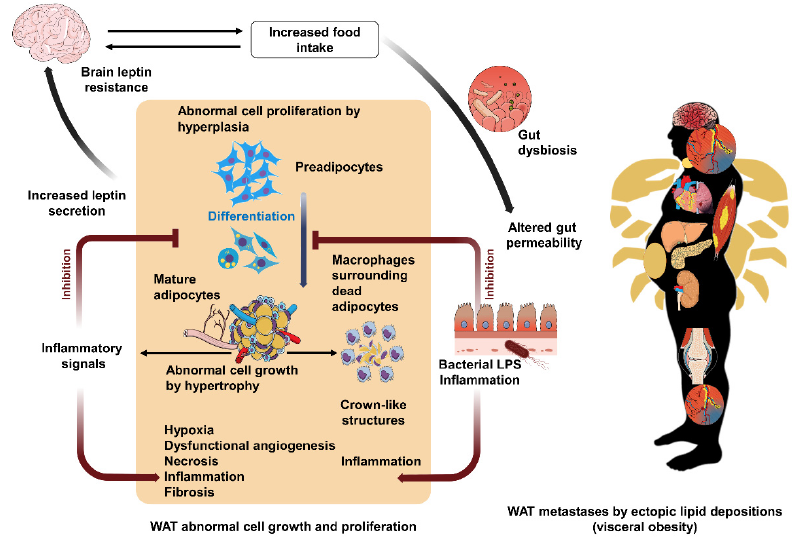
Figure 1. Vicious circles of white adipose tissue (WAT) abnormal cell growth and proliferation, and fat mass metastases. In obesity, the brain becomes less sensitive to the satiety hormone leptin, and this favors feelings of hunger and increases food intake. This further boosts the positive energy balance, induces intestinal flora dysbiosis and augments gut permeability to the bacterial endotoxin lipopolysaccharide (LPS), which is highly inflammatory. LPS inhibits the differentiation of preadipocytes to mature fat cells. Thus, more preadipocytes are formed to generate new adipocytes to store the body’s excess of energy, which enhances obesity by hyperplasia. The inhibition of adipogenesis induces mature adipocytes to undergo extreme abnormal cell growth to pack lipids that surpass their maximum storage capacity through excessive hypertrophy. This further causes hypoxia, fibrosis, and eventually cell necrosis. Massive WAT hypertrophy might induce severe hypoxia that can trigger angiogenesis, which, however, generates fragile and dysfunctional capillaries that further boost tissue inflammation. The dead adipocytes attract immune cells—macrophages—to form inflammatory crown-like structures. The affected WAT secretes high leptin levels to the brain to reduce food intake; however, the brain becomes insensitive to leptin due to the ongoing processes of obesity. WAT in the obese organism further secrets inflammatory cytokines to promote the inflammatory reaction in a chain of vicious circles that devastates WAT structure and function. This leads to lipid storage in other organs, like skeletal muscles and vital organs such as the heart, the liver, the kidneys, and the pancreas. Such expansion of WAT localization through ectopic fat depositions that embody “metastases” alters these organs functionality and therefore whole-body homeostasis. In addition, accumulated free fatty acids in blood circulation may injure endothelial cells through provoking oxidative and inflammatory reactions, which might hasten atherosclerotic plaque rupture. This can cause venous or arterial thromboembolism, which can present fatal consequences when affecting vital organs, such as in pulmonary embolism, heart attack, and stroke. These biological alterations are accompanied by those starting from a mechanical origin, such as body weight pressure on the bones and joints or airway blockage, to induce osteoarthritis or obstructive sleep apnea, respectively. These crab (cancer)-leg-like projections of cell growth, cell proliferation, and fat ectopic depositions, and their impact on the whole body in obesity, justly present high similarity with cancer disease metastases. Created with BioRender.com and with MindtheGraph.com. Accessed on 24 March